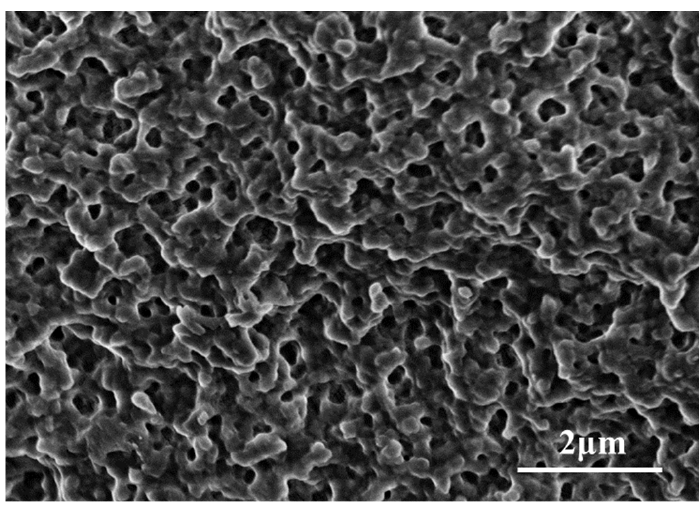
Figure 6. SEM images of the internal structure of ion exchange resin. Table 1. Characteristics of resins.